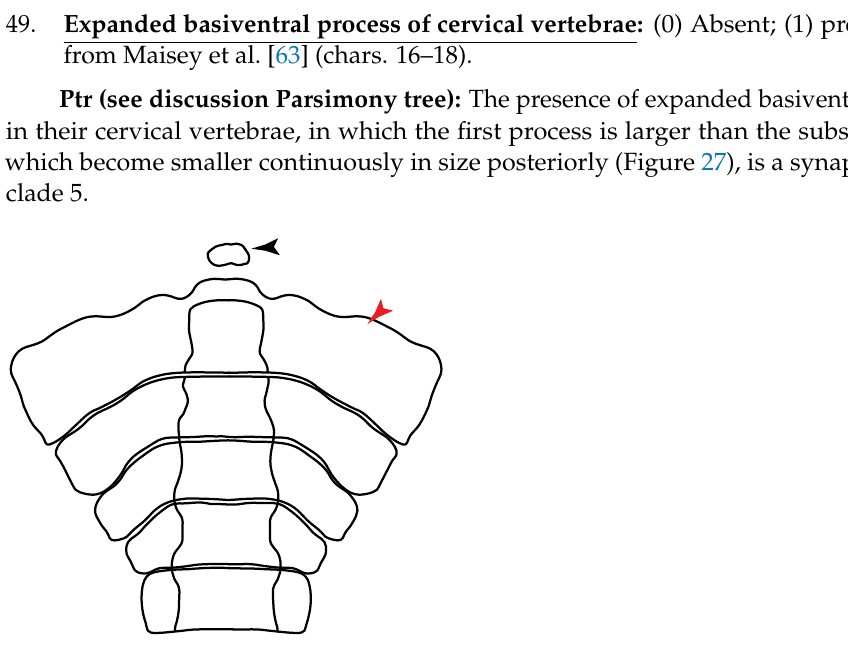
Figure 27. State (1). Interpretative drawing of the first cervical vertebrae of Squatina punctata in ventral view (ZMB 33878) redrawn and modified from Claeson and Hilger Text-Figure 2A in [103]. Black arrowhead: occipital hemicentrum; red arrowhead: basiventral process of cervical vertebra. 51. Lateral stays: (0) Fused distally with medial crest; (1) free of medial crest (new). Taxa with no synarcual (i.e., outgroups) or with no lateral stays on the cervicothoracic syn- arcual (i.e., Chimaera and Harriotta ) are coded as inapplicable (-), which makes the